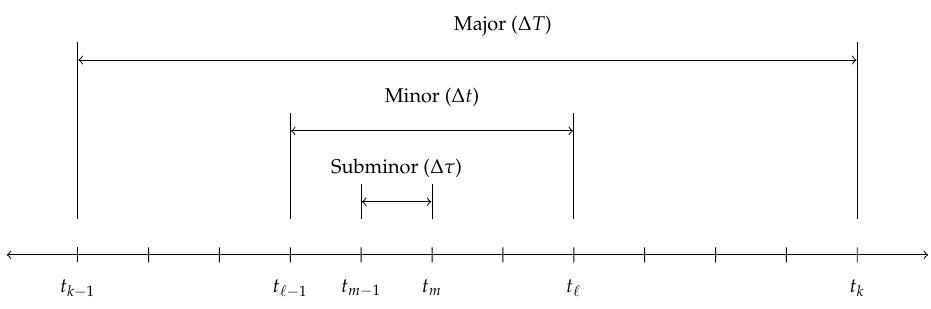
Figure 1. Major, minor, and subminor time intervals considered by the